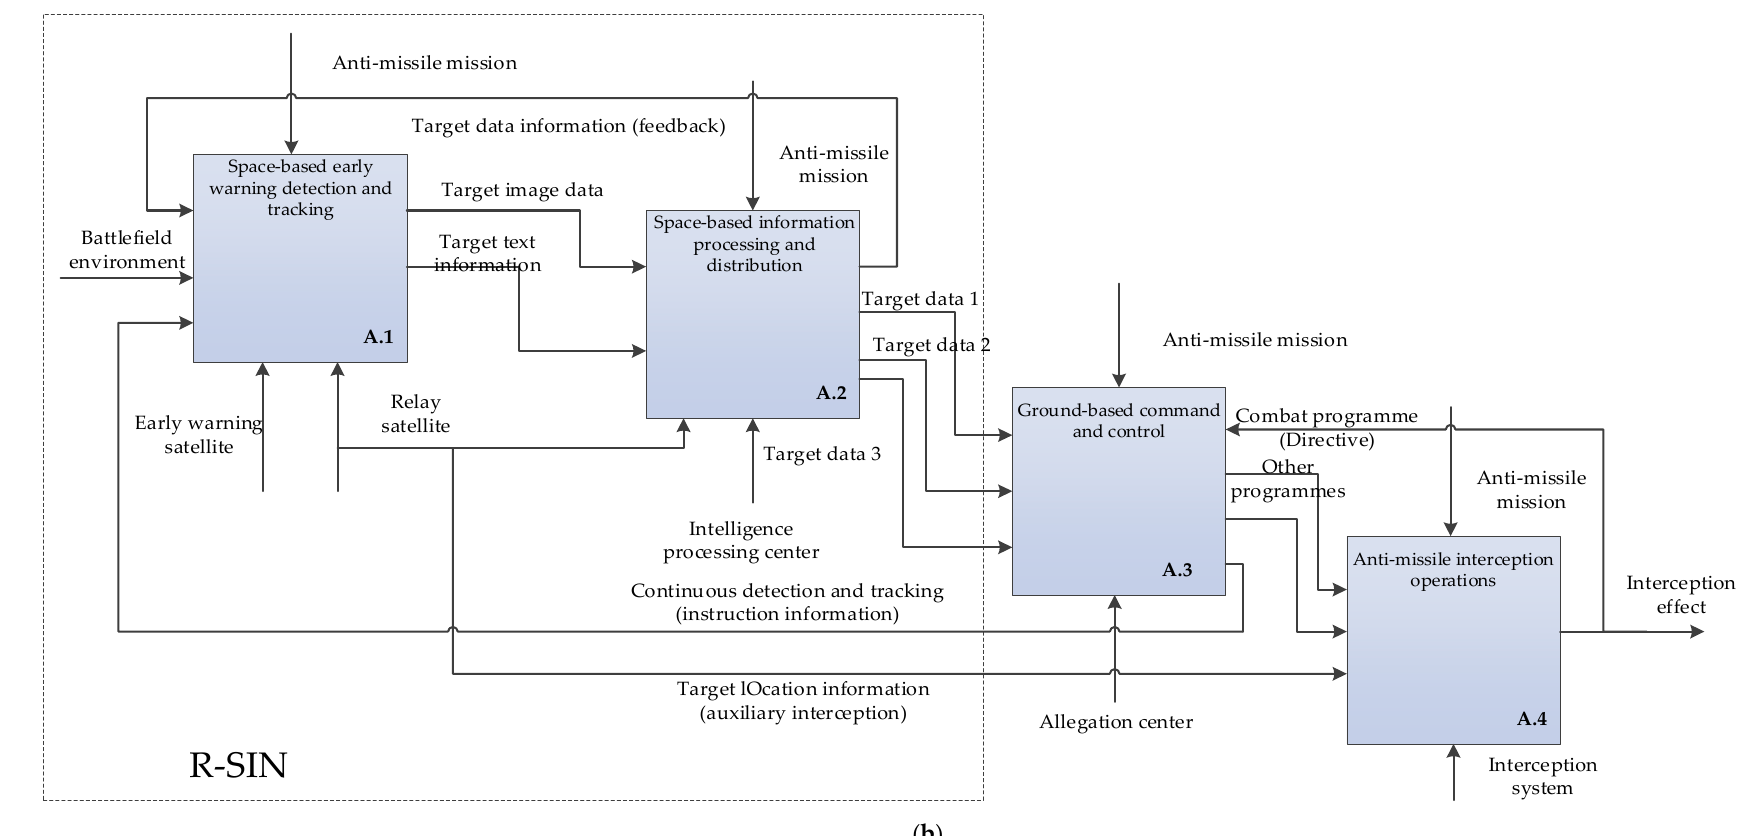
Figure 9. R-SIN combat activity decomposition model supporting anti-missile tasks: ( a ) the first-level combat activity decomposition model; ( b ) the two-level combat activity decomposition model.